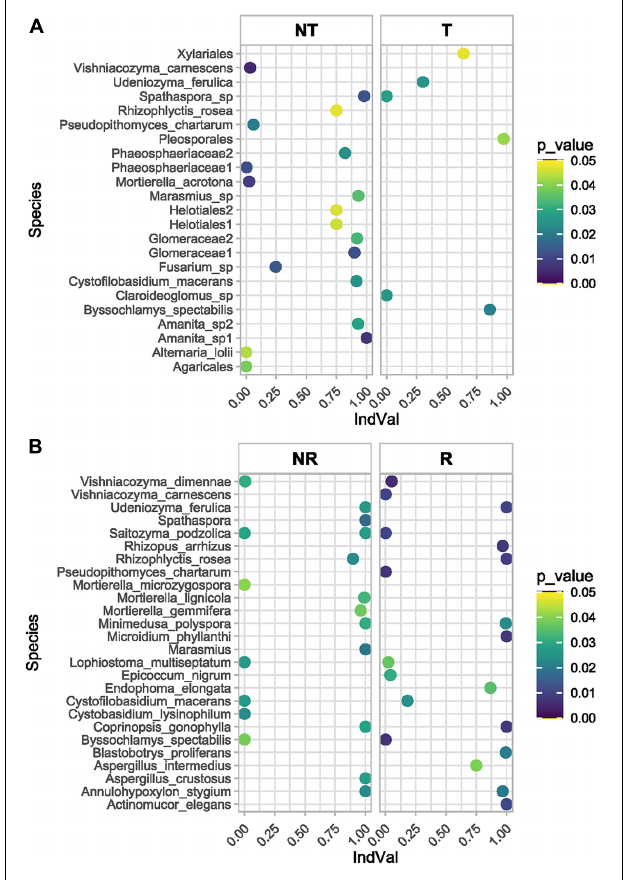
FIGURE 9 | The indicator species analysis (see also Supplementary Table 6 ) assigned a significative indicator value (IndVal) to several unidentified OTUs. Among the identified OTUs the top indicator species of the site-group combination NR (T vs. NT) are shown in the plot (A) , while the top indicator species of the site-group combination R (T vs. NT) are shown in the plot (B)